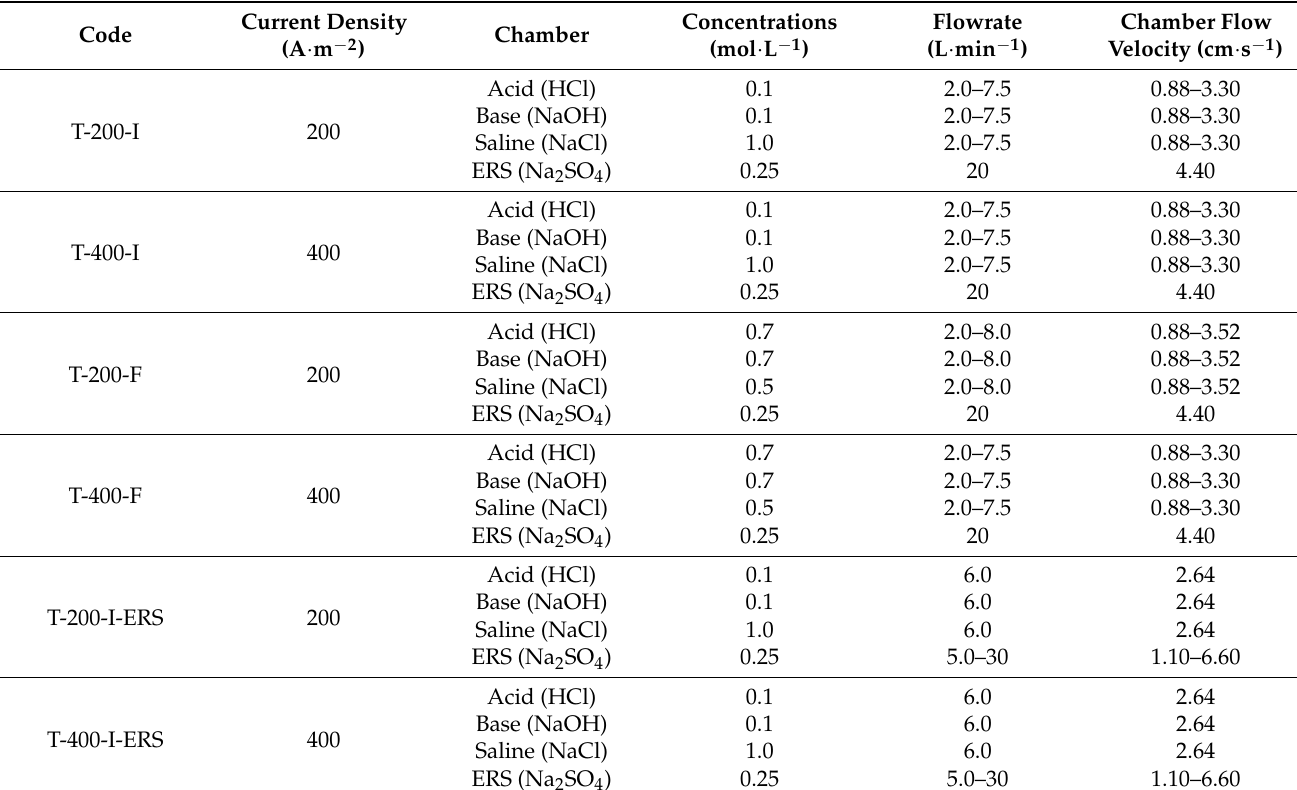
Table 2. Summary of the experimental conditions of the performed